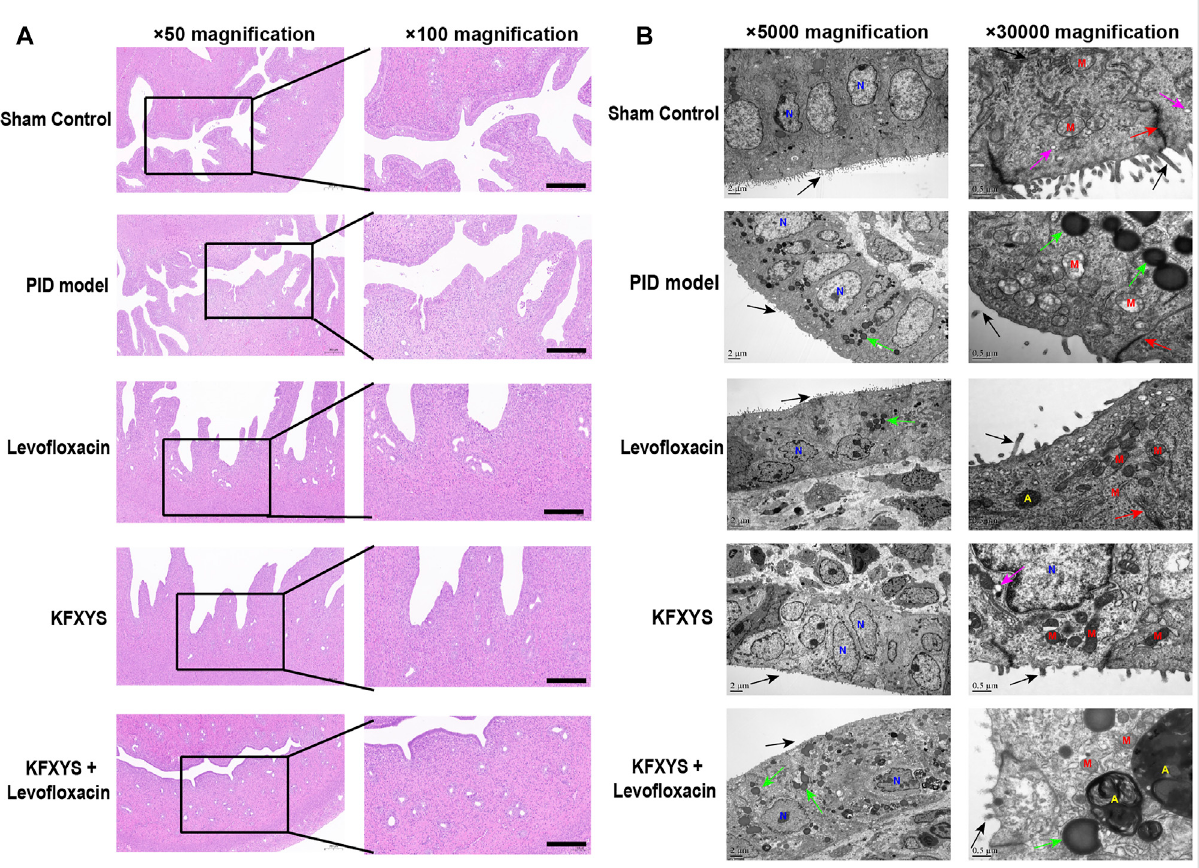
FIGURE 2 In fl ammatory changes in uterine tissue associated with drug treatment during the acute in fl ammation phase (D3). (A) Changes in in fl ammatory cells in the uterine mucosa were observed by HE staining. In the PID model group, the epithelial cells were hyperplastic and dense, showing papillary protrusion into the uterine cavity, some interstitial structures were destroyed, and a large number of chronic in fl ammatory cells wereobservedinthemucosallayerandmusclelayer.IntheLevo fl oxacinorKFXYSgroup,theformationofpapillaryprotrusionsbyepithelialcell proliferationwasreduced,andtherewasasmallnumberofin fl ammatorycellsandin fi ltratingneutrophilsinthemucosallayer.Therewerealmostno in fl ammatory cells and epithelial and glandular structures were intact in the KFXYS+Levo fl oxacin group. Images were taken at 50× or 100×; magni fi cation. Scale bar: 100 μ m. (B) Ultrastructural changes in the uterine mucosa of rats observed by TEM. Intact microvilli (black arrows), intercellular connections (red arrows), secretory vesicles (purple arrows), and lipid droplets (green arrows) were observed. N, nucleus; M, mitochondrion; A, autolysosome. Images were taken at 5000× or 30000× magni fi